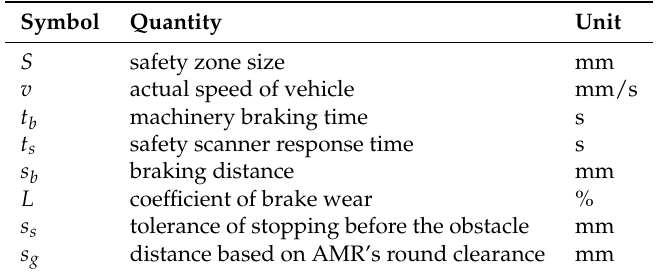
Figure 6. Parameter s g as a function of vehicle ground clearance h . Table 2. Parameters for calculation of safety zone size from Equation (8).